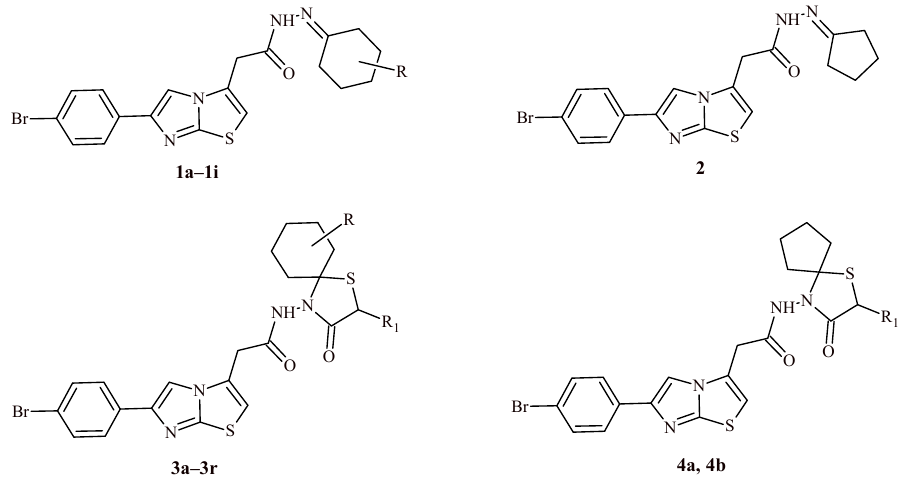
Figure 1. Imidazo[2,1- b ]thiazole-thiazolidin-4-one hybrids ( 3a – 3r , 4a and 4b ) and their precursors ( 1a – 1i and 2 ) with antioxidant activity. ( 1a – 1i and 2 ) with antioxidant